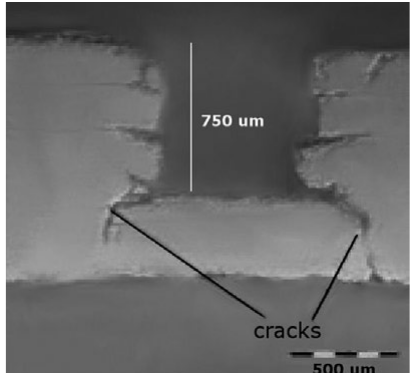
Fig. 3. Tearing effect can be observed around the channel outlet as a consequence of the inhomogeneous forces during lamination ( source : own